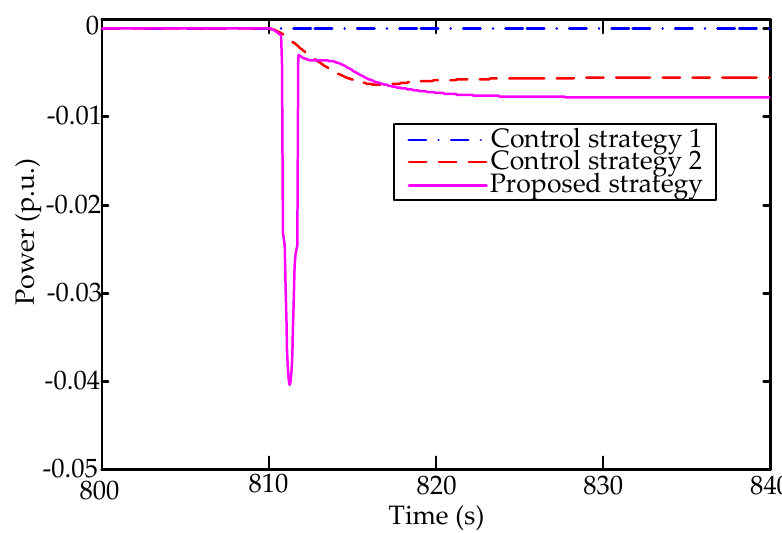
Figure 6. The power output of aggregated ACs under different control schemes. Table 3. Simulation results of Case 1.